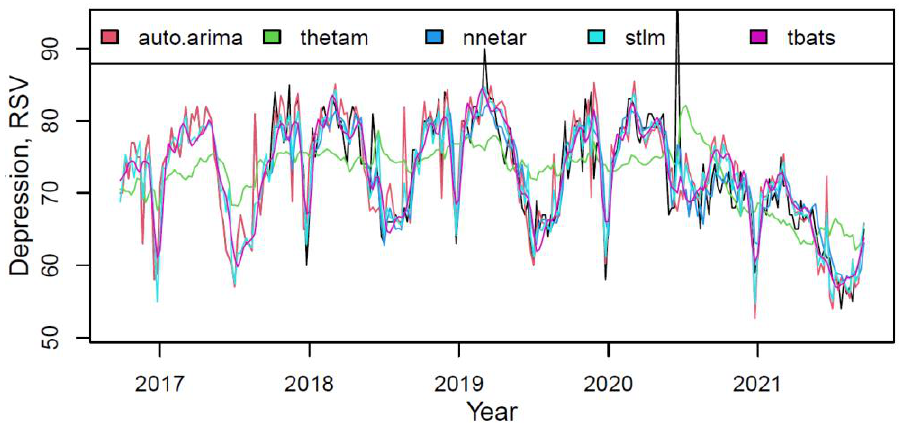
Figure 1. The actual (black) and fitted values of each component of the M2 hybrid model.